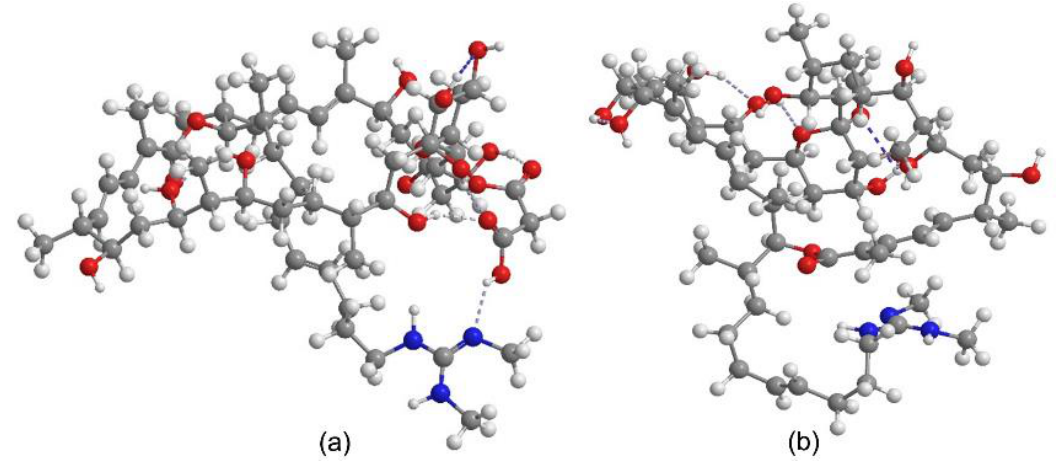
Figure 6. The 3D molecular structures of azalomycin F 5a ( a ) and 23-demalonyl azalomycin F 5a ( b ) obtained by ChemBio3D Ultra 12.0. ( a ) An intramolecular hydrogen bond or ionic bond (dotted line) is formed between the guanidyl (nitrogen atoms colored blue) of side-chain and the carboxyl group (oxygen atoms colored red) of malonyl monoester, but there is no bond formation in case of ( b ).